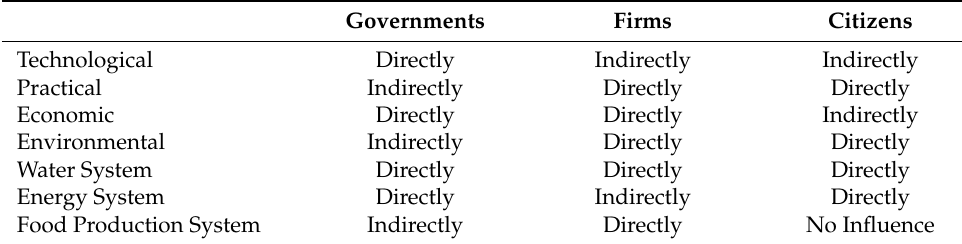
Table 4. Relationships between involved